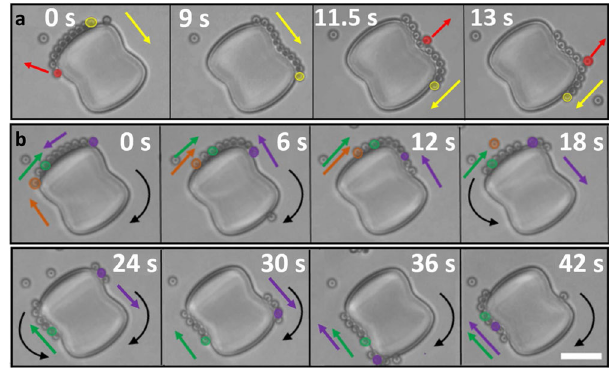
Fig. 5 Dynamics of activity-assembled chains: effect of post curvature on chain mobility. a A swimmer leaves from the end of the self-propelled compact chain when it reaches the rounded post edge ( t = 0 s). Swimmers from the middle of the chain escape on the neck or the rounded post edge ( t = 11.5 and 13 s). Red particles and arrows mark swimmers escaping the chain. See Supplementary Movie 7. b Local curvature variation facilitates pinning and chain breakup. The same colors correspond to the same swimmer within each time series, except the red color in a . Colored arrows denote the direction of motion of individual swimmers with the corresponding color. Curved black arrows indicate the motion of the chain(s) as a whole, absence of curved arrow denotes that the chain momentarily remained stationary. See also Supplementary Movie